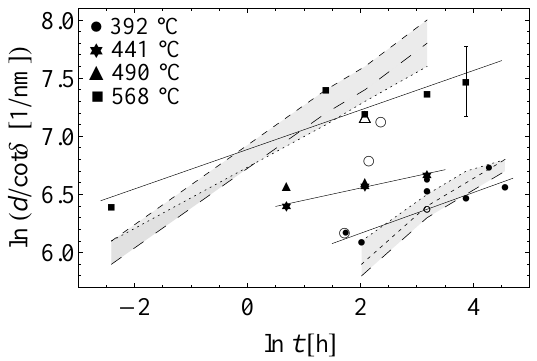
Figure 12. Correlation of the average ratio of groove depth and cotangent of groove-root angle with annealing time for experiments run at indicated temperatures and a pressure of ∼ 200MPa. The standard deviation of the observations is given by vertical error bars for only one representative example out of presentational reasons. Only those grooves were used to determine average groove parame- ters at given conditions that exhibit a width/depth ratio that does not deviate from the value of the Mullins’ theory by more than 0.15 (see Eqs. 3 and 4). The solid lines represent linear regressions for sub- groups of the data set (solid circles 392 ◦ C, solid stars 441 ◦ C, and solid squares 568 ◦ C). The slope corresponding to the inverse of the growth exponent n is less than that of the dashed lines, representing the results of the inversion for kinetic parameters of the three con- sidered scenarios, interface diffusion (dotted line, n = 4), diffusion through liquid (short dashed, n = 3) and diffusion through the solid (long dashed, n = 3) (see Eq. 4 and Table 3) and thus, at face value, the data yield growth exponents larger than the ones predicted by Mullins’ theory. The open triangle represents an experiment with added SiO 2 powder. The large open circles indicate the sequential experiment that were not included for the